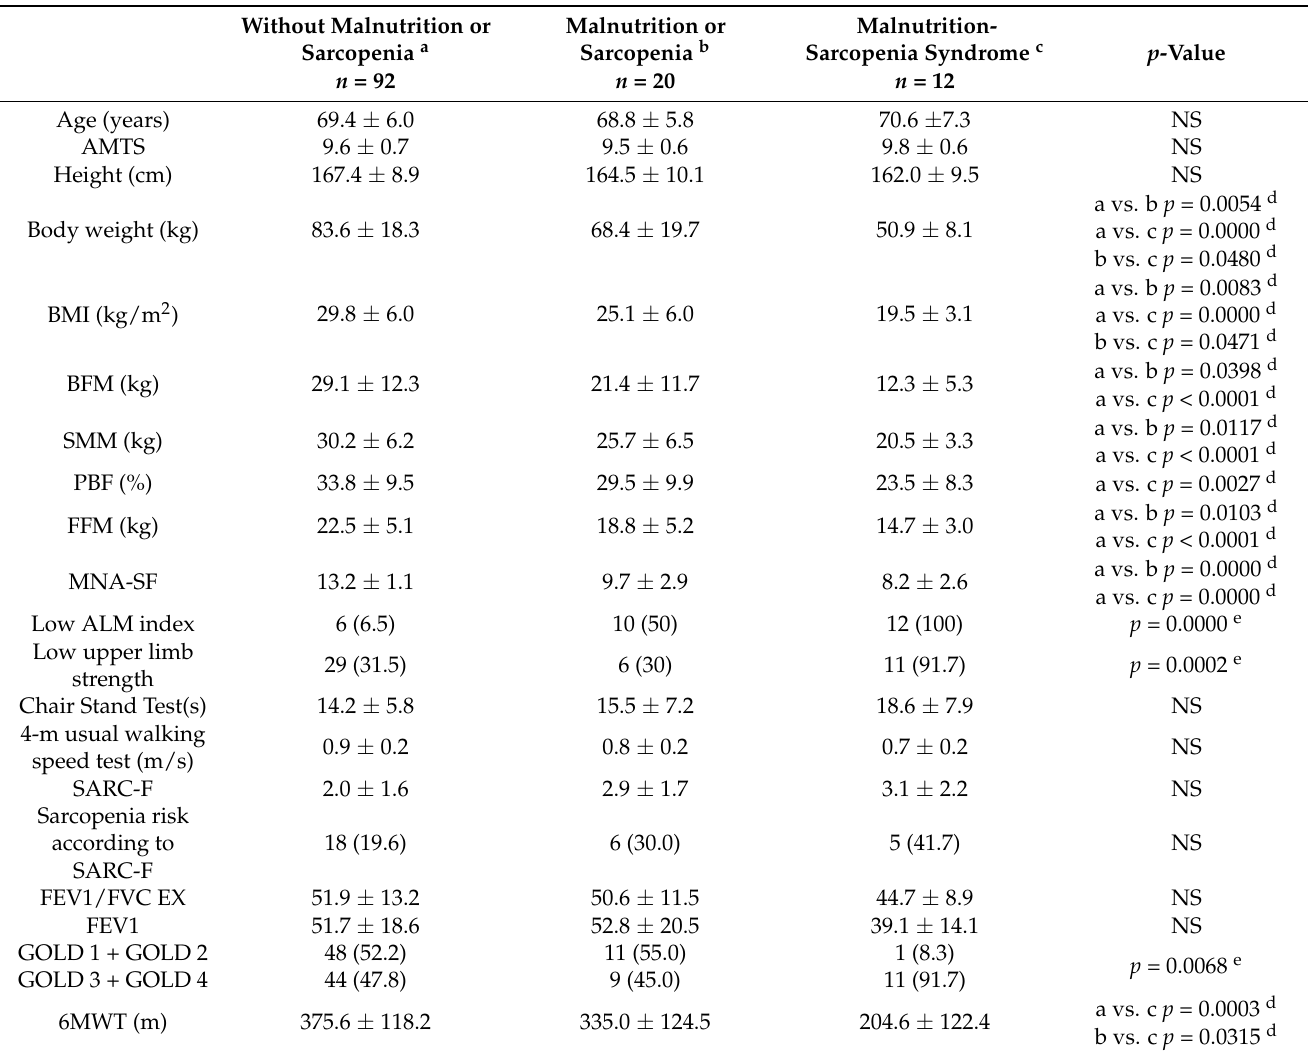
Table 4. Comparison between participants without malnutrition or sarcopenia, subjects with malnu- trition or sarcopenia, and patients with malnutrition-sarcopenia